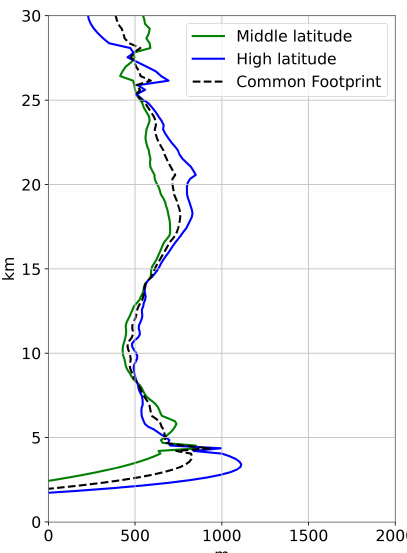
Figure 8. Estimates of the ERA5 vertical footprint for middle and high latitudes. The effect of filtering of RO and RS92 on the esti- mated ERA5 error standard deviation, σ ERA5 , is shown in Fig. 7a. The ERA5 vertical footprint is found for each altitude as the filter width which minimizes σ ERA5